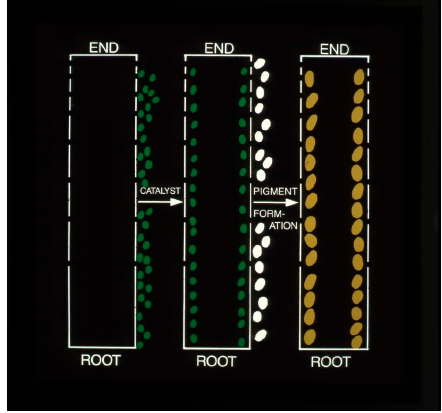
Figure 21. Coloring of hair with melanin precursor.